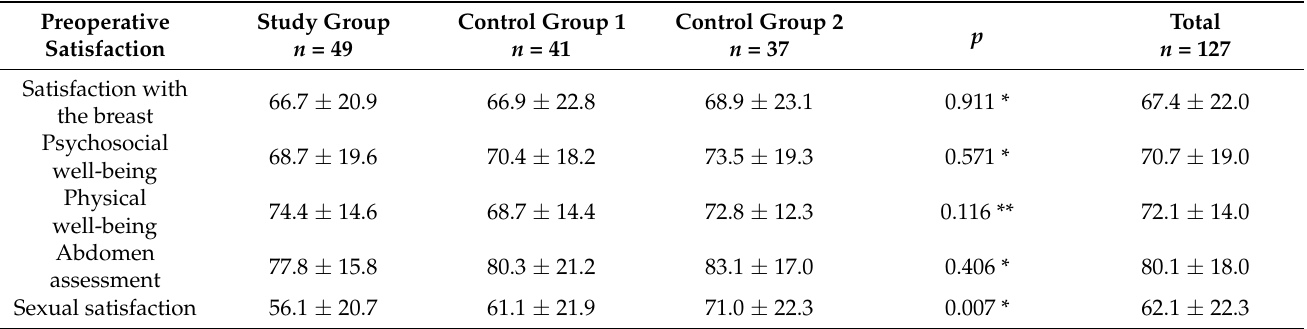
Preoperative Breast Q questionnaire (30 patients who did not answer the survey were